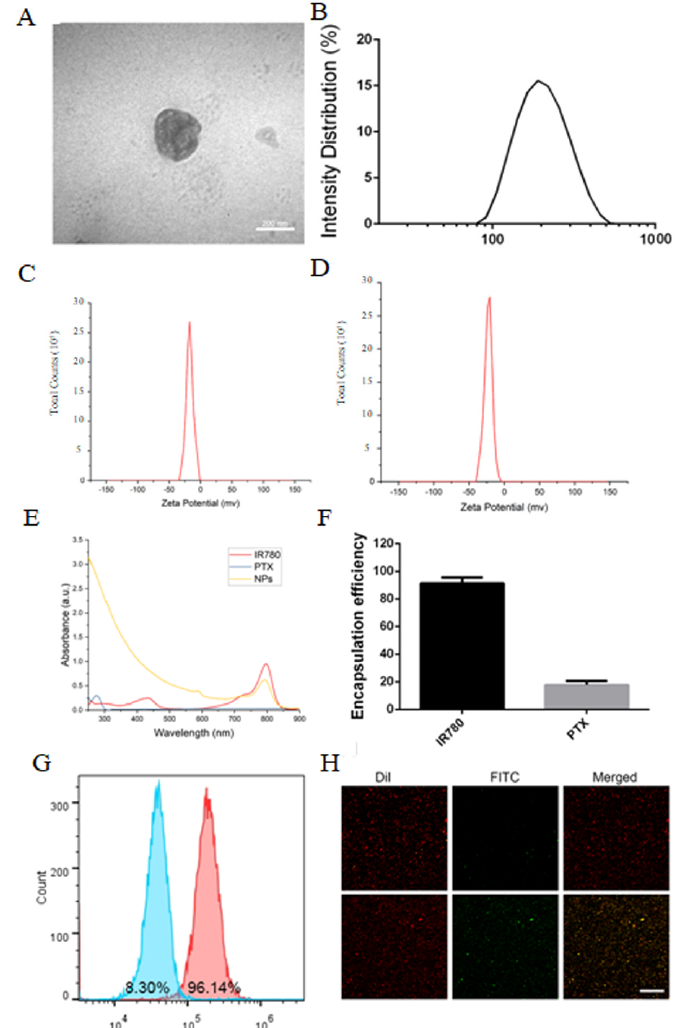
Figure 1. Characterization of PSMA − targeted PFP@IR780@PTX@liposomes: ( A ) TEM image; ( B ) Size distribution; ( C ) Zeta potential of the untargeted nanoparticles. ( D ) Zeta potential of the PSMA − targeted nanoparticles. ( E ) The absorption spectra of IR780, PTX, and PSMA − targeted nanoparticles. ( F ) The encapsulation efficiencies of IR780 and PTX. ( G ) The connection efficiency of PSMA and nanoparticles by flow cytometry (Left: control; Right: PSMA − targeted nanoparticles). ( H ) CLSM (Up: control; Down: PSMA − targeted nanoparticles). Scale bar: 50 μ m.